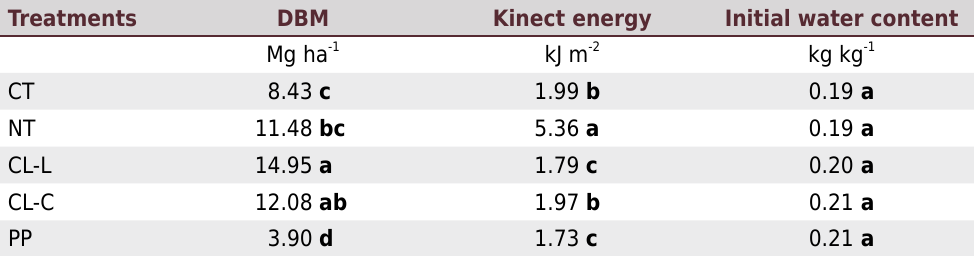
Table 3. Average values of dry plant mass (DBM), the kinetic energy of the rainfall simulations, and the initial water